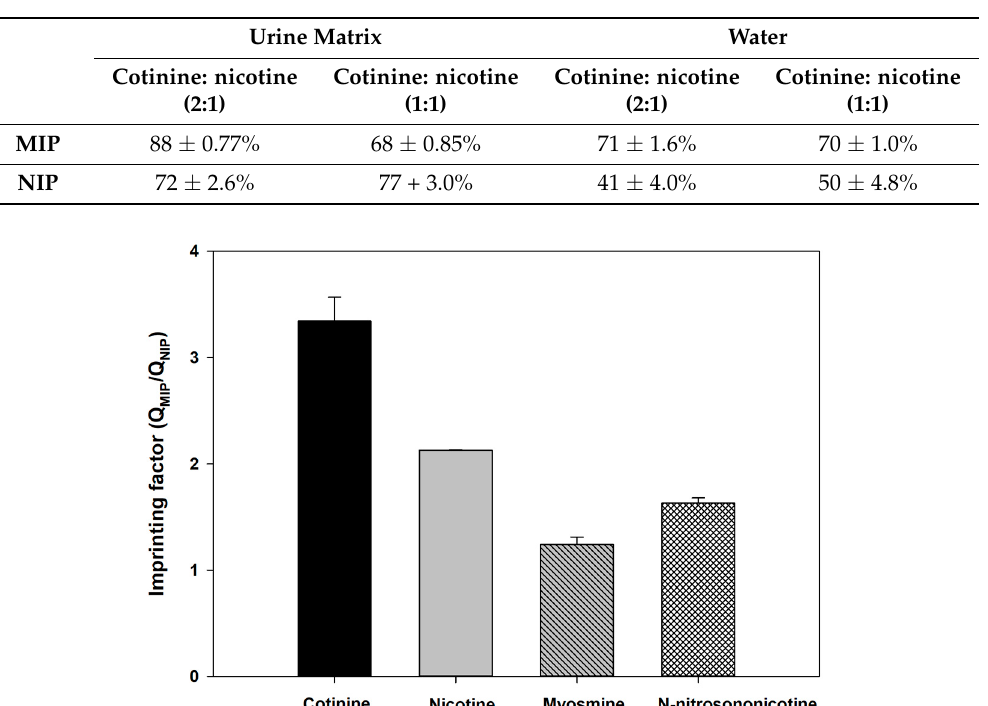
Table 1. Recovery of MIP and NIP paper-based scaffold in urine matrix and water with the presence of nicotine at ratios of 2:1 and 1:1.